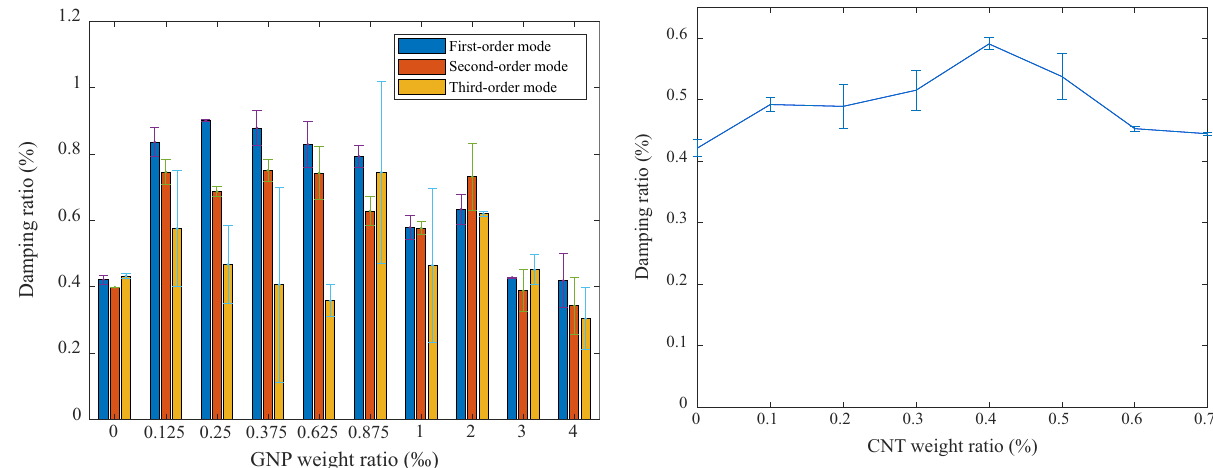
Figure 11: First - order damping ratios of the composite beams rein - forced by CNT through vibration tests.